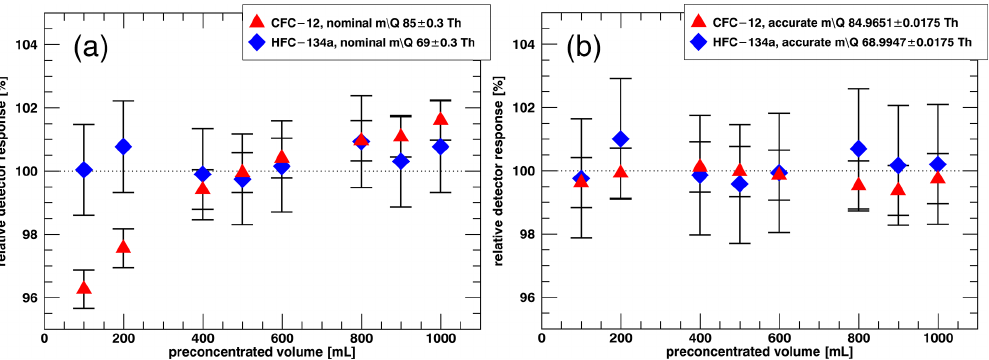
Figure 8. Relative detector responses ( y axis) derived for different preconcentration volumes ( x axis) of the same reference gas. Relative responses were calculated relative to the detector response of calibration points with a preconcentrated volume of 0.5L. Error bars: 3-fold measurement precision of the respective substance. (a) Results based on nominal mass data; (b) results based on accurate mass data. While HFC-134a (blue diamonds) does not deviate significantly from linearity in either of the panels, a systematic non-linearity is observed for CFC-12 (red triangles) in (a)